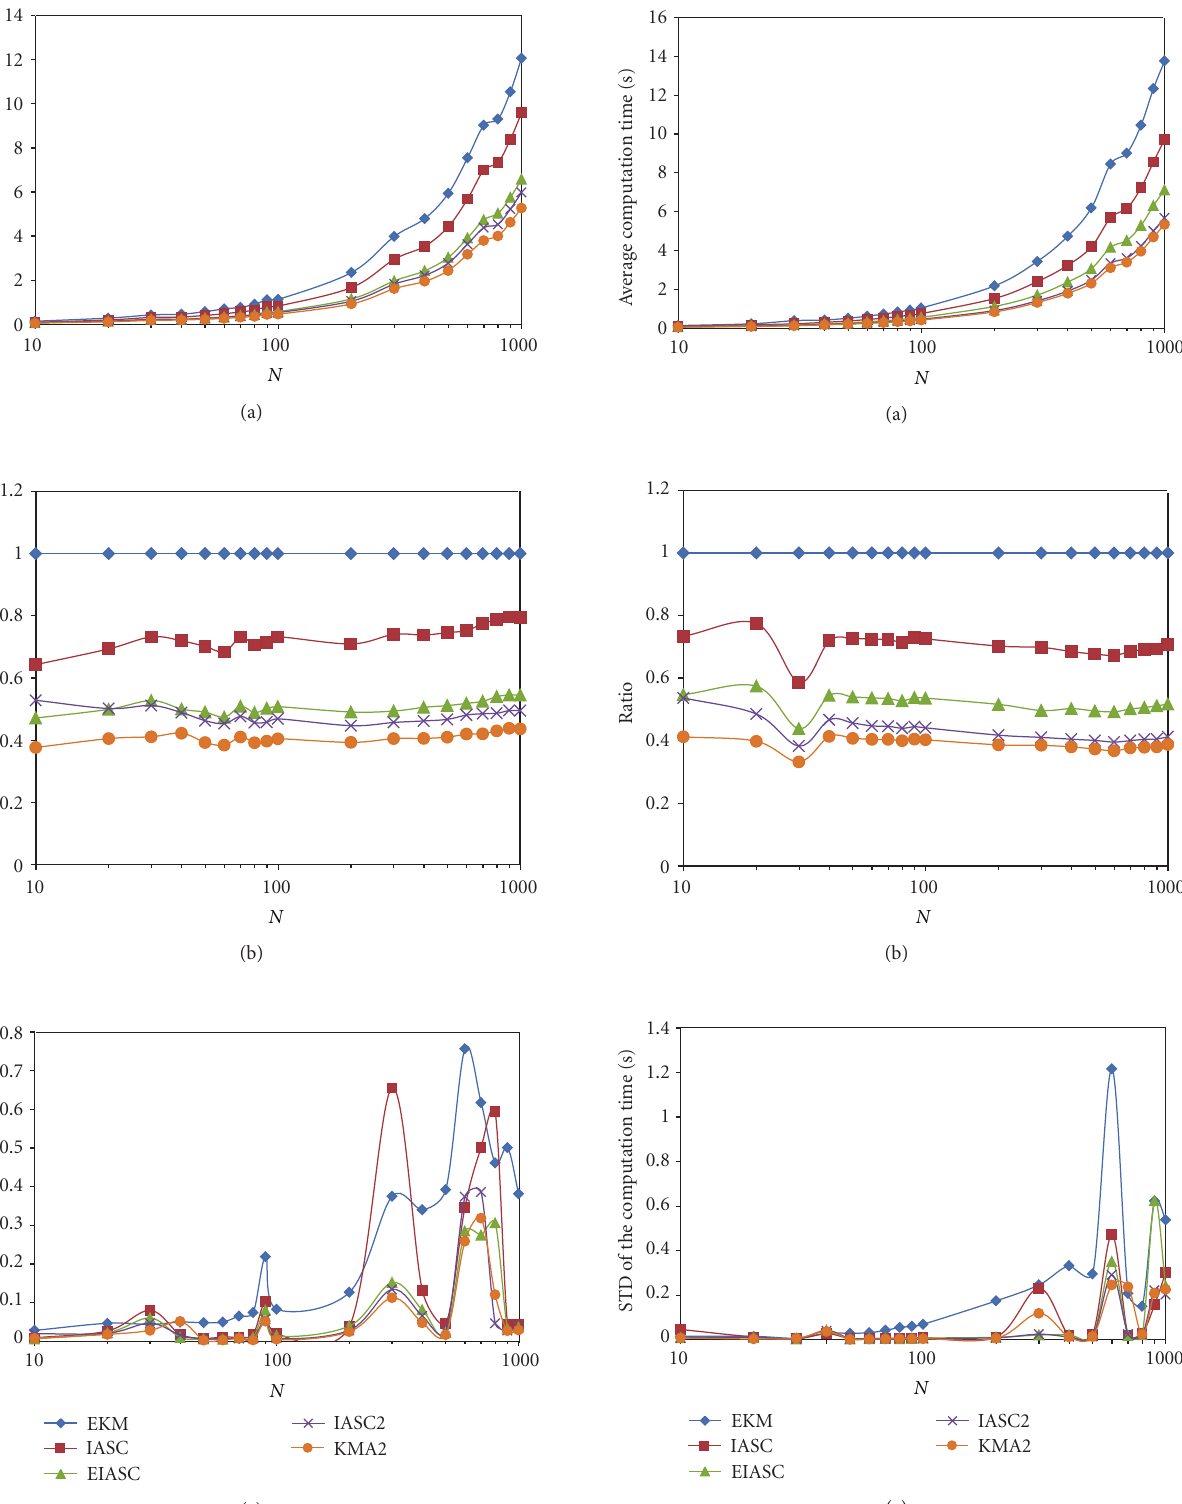
Figure 12: Centered random FOU results (interpreted language implementation of the algorithms). (a) Average computation time, (b) ratio with respect to the EKMA, and (c) standard deviation of computation